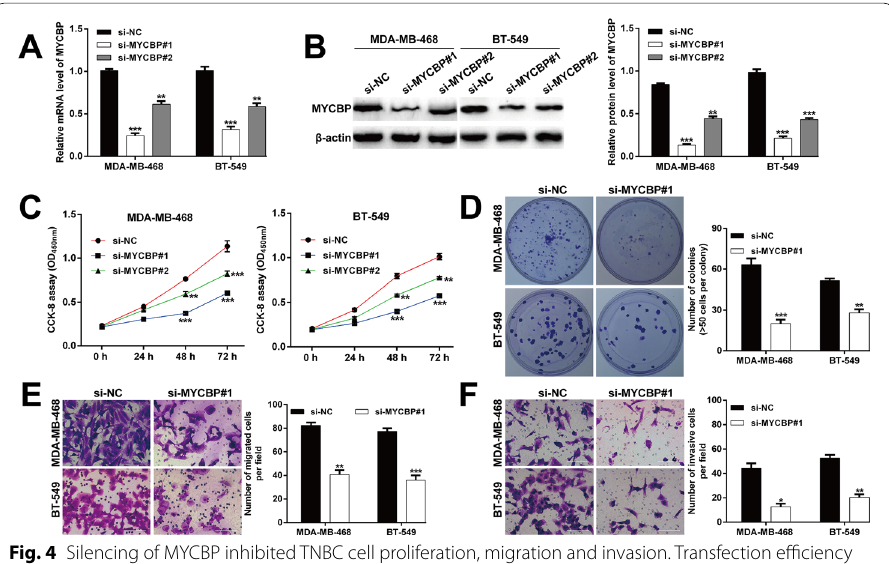
Fig. 4 Silencing of MYCBP inhibited TNBC cell proliferation, migration and invasion. Transfection efficiency of si-MYCBP # 1 or si-MYCBP # 2 in MDA-MB-468 and BT-549 cells was detected by PCR assay ( A ) and western blot analysis ( B ). C CCK-8 assay was used to determine the cell viability of MDA-MB-468 and BT-549 cells after transfection with si-MYCBP # 1, si-MYCBP # 2 or si-NC. D The influence of MYCBP knockdown on cell proliferation